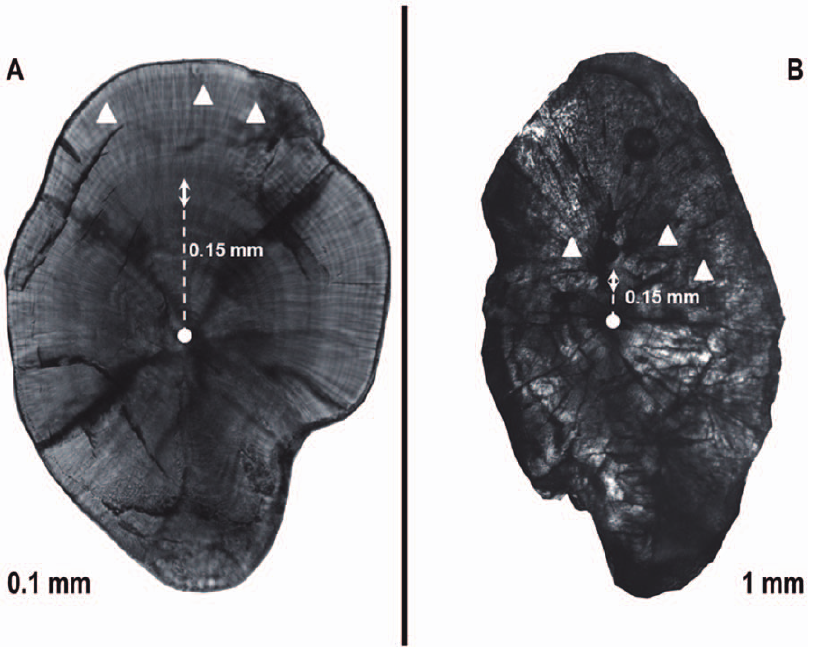
Figure 2. Otoliths of a) settler and b) recruit specimen. Photos are taken at different magnification: 200 6 for a) and 40 6 for b). Dots indicate cores, triangles indicate ablations in juvenile region, double arrowed lines indicate settlement marks. Dotted lines indicated distances between core and settlement mark.